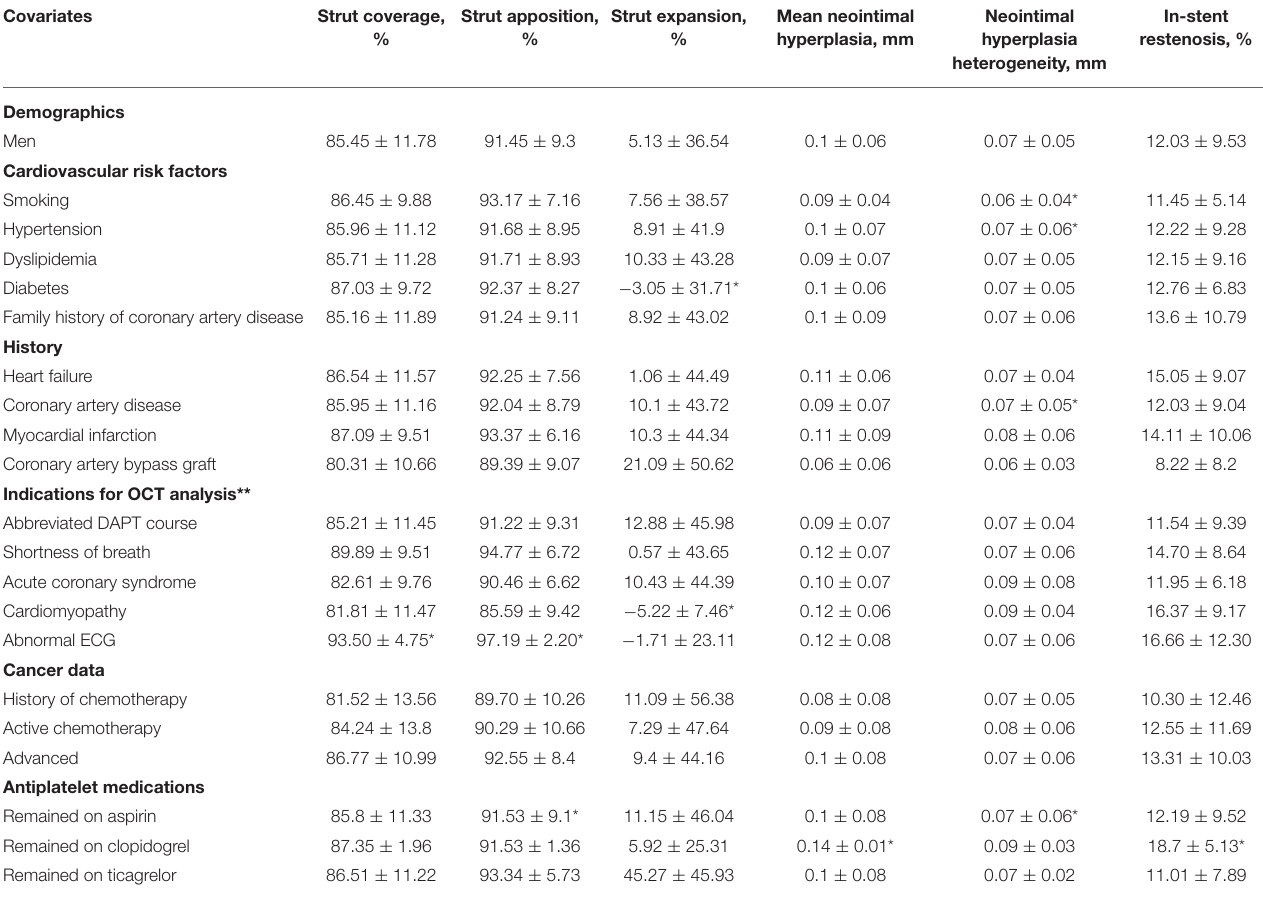
TABLE 2 | Descriptive OCT stent measurements ( N = 97 stents in 67 patients). Covariates Strut coverage,